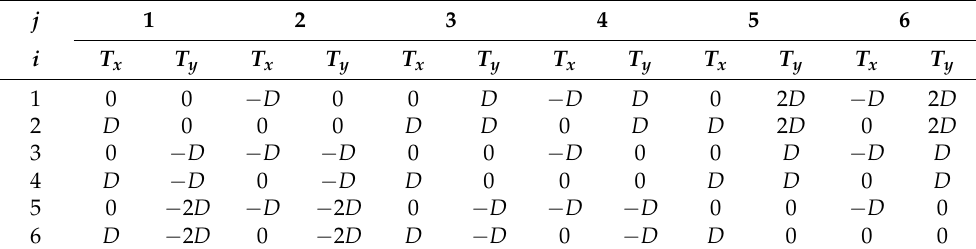
Table 2. Final formation distance between robots in the 6-robot experiment.